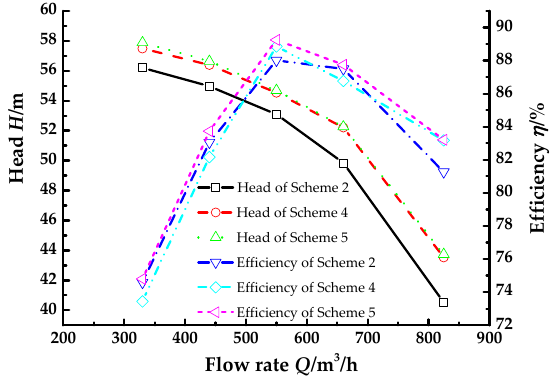
Figure 17. Hydraulic performances of the centrifugal pump with different blade exit angles.